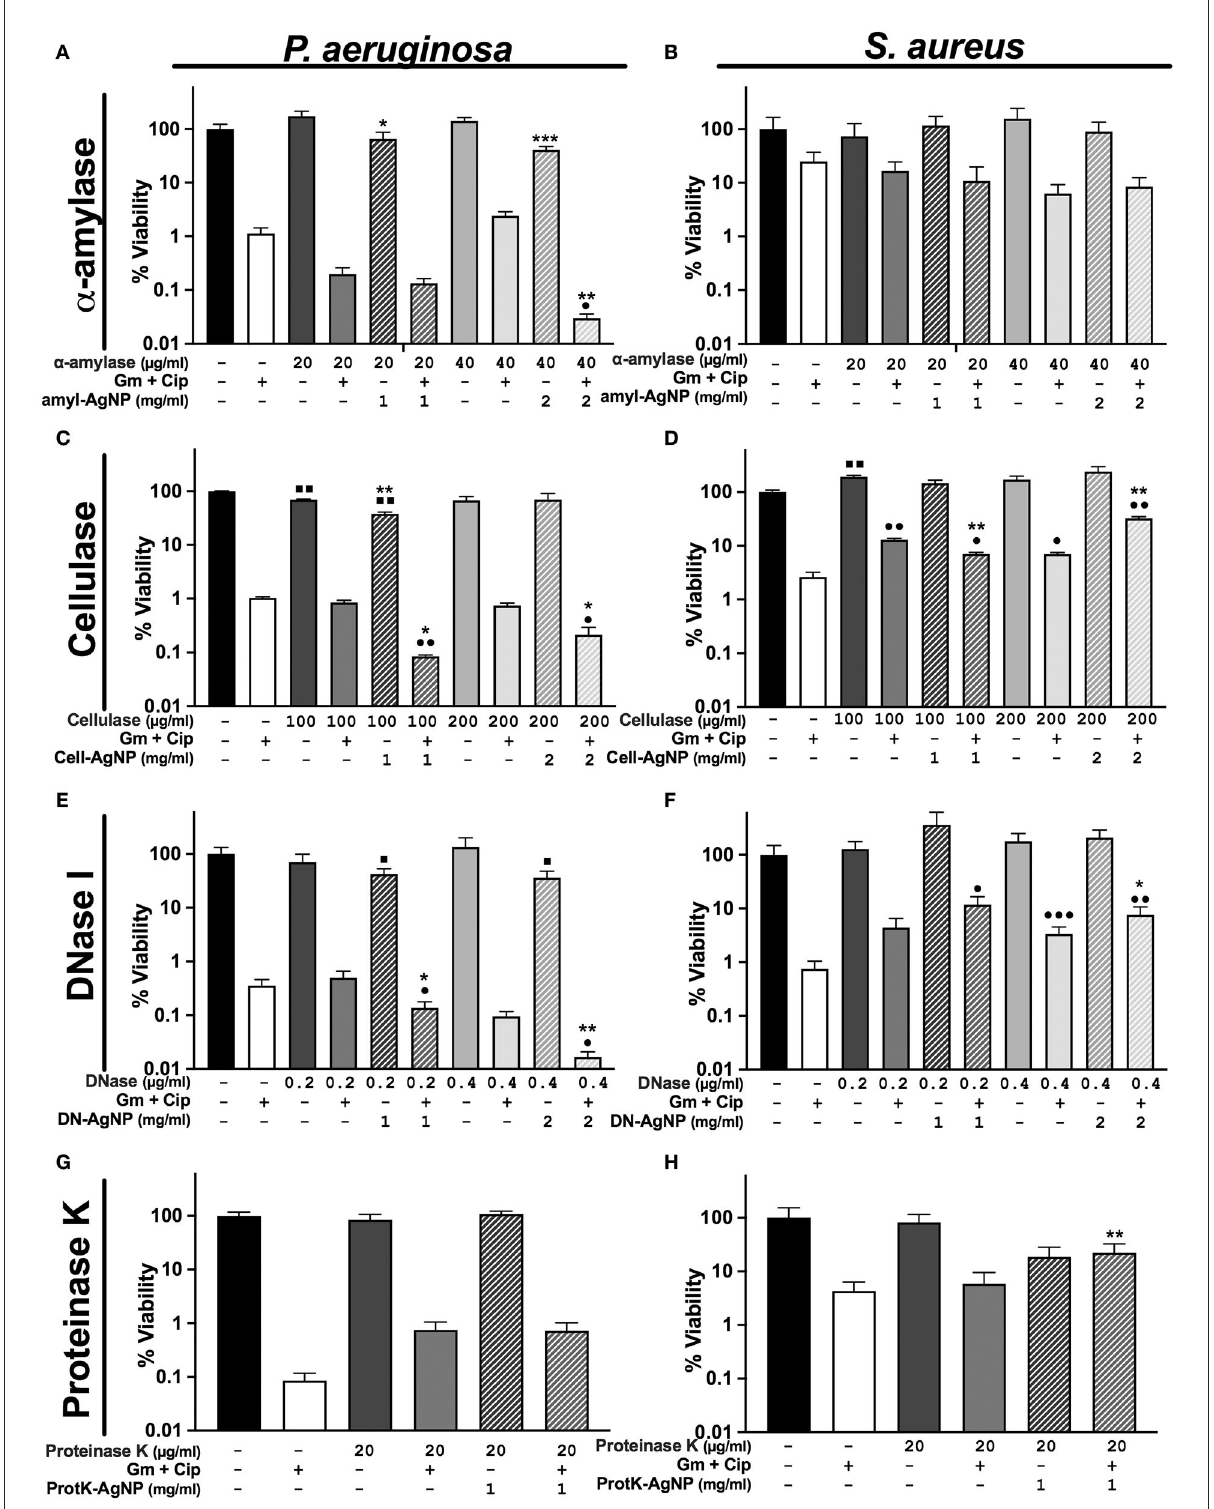
FIGURE4 Differential response of antibiofilm treatments on P. aeruginosa and S. aureus polymicrobial WLB. WLB antimicrobial assays show the effect of the antibiofilm treatments consisting of ciprofloxacin (Cip) and gentamicin (Gm) antibiotics at a final concentration of 13.5 µ g/ml each, along with a biofilm-dispersing enzyme in solution or functionalized on AgNP at a final concentration of 1 or 2 mg/ml. The concentration of enzyme indicated above the concentration of AgNP corresponds to the amount of enzyme functionalized on AgNP. Percentage of viability corresponds